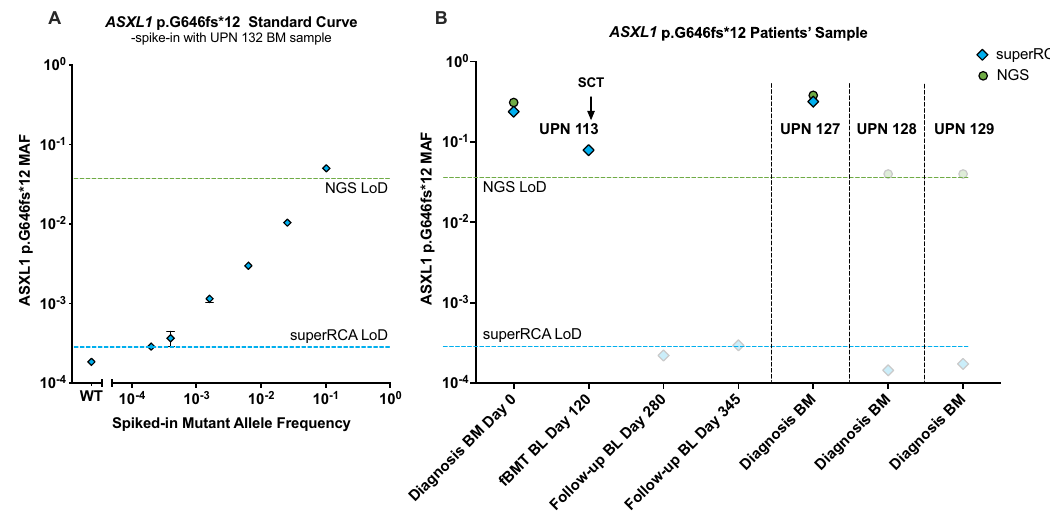
Fig. 7 Analysis of the GC-rich ASXL1 p.G646fs*12 mutation in hematological malignancies. A Standard curve of genomic DNA with the GC-rich ASXL1 p.G646fs*12 mutation, serially diluted 4-fold in wild-type gDNA and analyzed by superRCA in duplicates. B superRCA analysis of BM and blood samples from four individuals with AML and MDS, positive for the ASXL1 p.G646fs*12 mutation by NGS